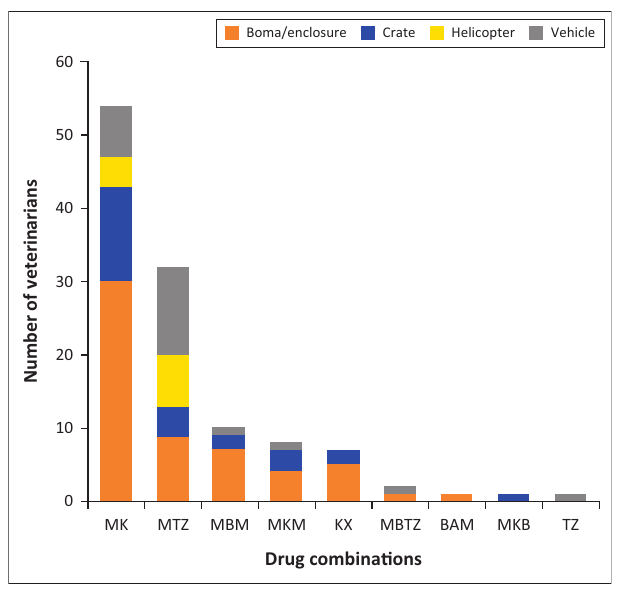
FIGURE 1: Stacked bars showing the number of veterinarians that reported the use of different combinations of medicines used to immobilise cheetahs under various capture conditions.